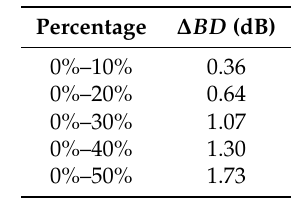
Figure 6. Rate-distortion convex hulls for each packet loss percentage for the reconstruction of N = 512 samples of a temperature signal with LASSO, considering the transmission of 1 CS measurement per packet. Table 2. ∆ BD between rate-distortion (RD) curves for each packet loss percentage for the reconstruction of N = 512 samples of a temperature signal with LASSO, considering the transmission of 1 CS measurement per